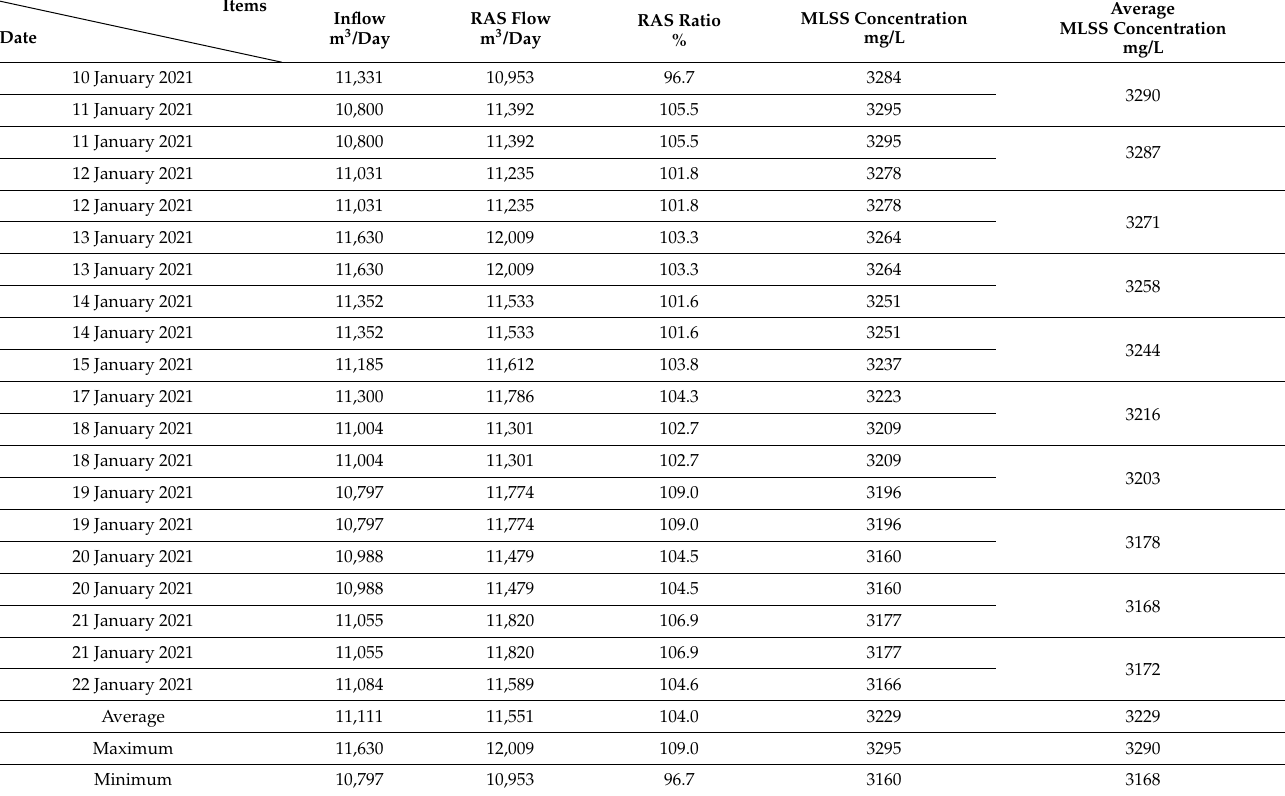
Figure 5. Diurnal variation in secondary effluent SS concentrations at the secondary clarifier at plant B during the sampling period. Table 6. Daily inflow, RAS flow, RAS ratio, and MLSS concentrations on each sampling day at plant B.